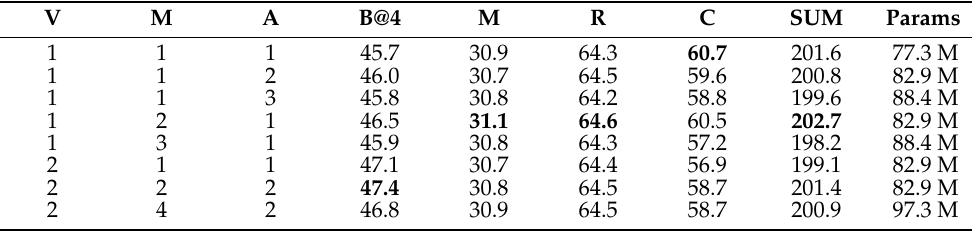
Table 4. Experimental results of assigning different depths to each modality by SME. V, M, A represent the layer number of video, motion, and audio, respectively. SUM represents the sum of four metrics. The maximum value of each column is marked in